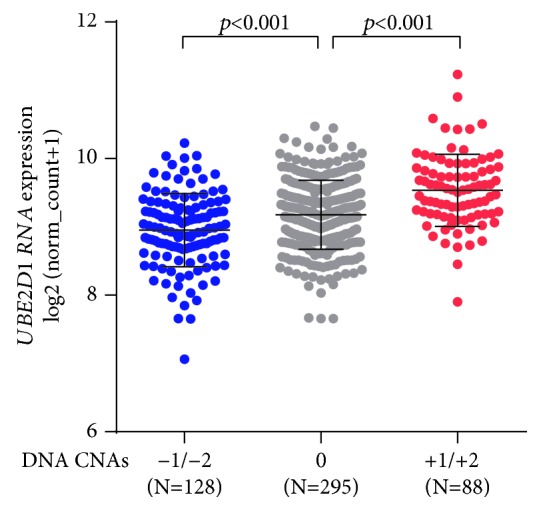
The association between UBE2D1 CNAs and UBE2D1 RNA expression. Comparison of UBE2D1 RNA expression in different CNA groups. CNAs were defined as homozygous deletion (−2), heterozygous loss (−1), copy neutral (0), low-level copy gain (+1), and high-level amplification (+2).